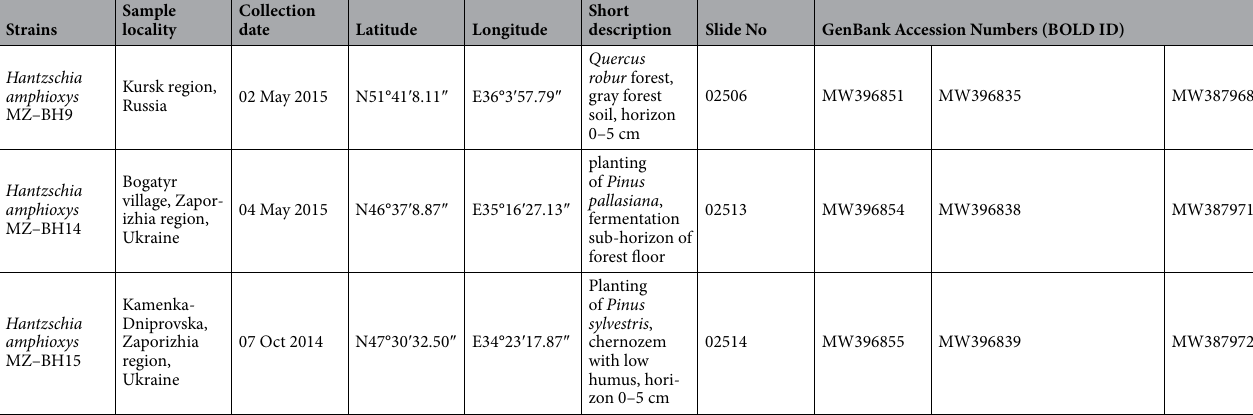
Table 2. List of all strains examined in this study with their GenBank accession numbers (BOLD ID). Geographic position and description of sample sites